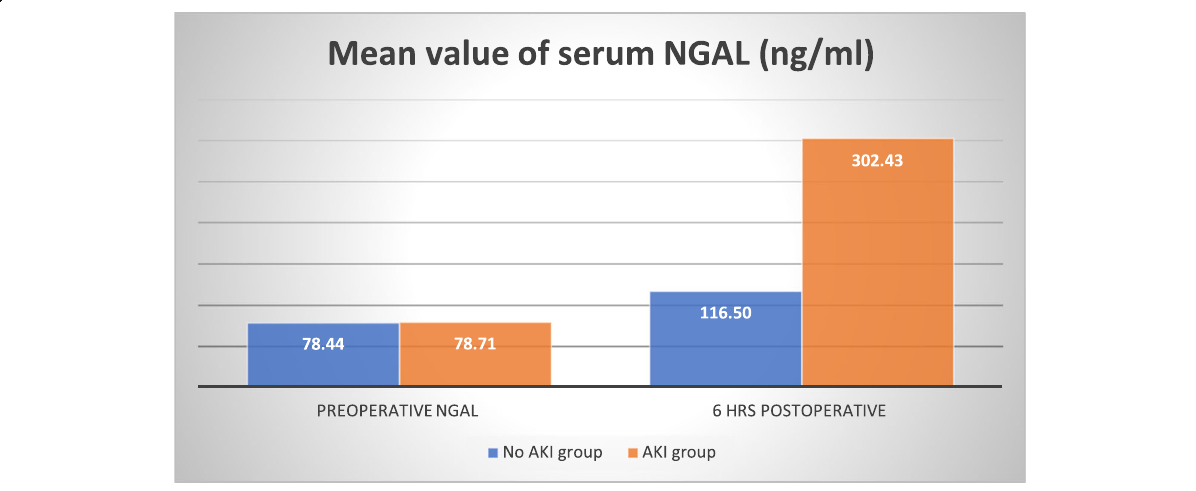
Fig. 2 Mean value of plasma NGAL in both